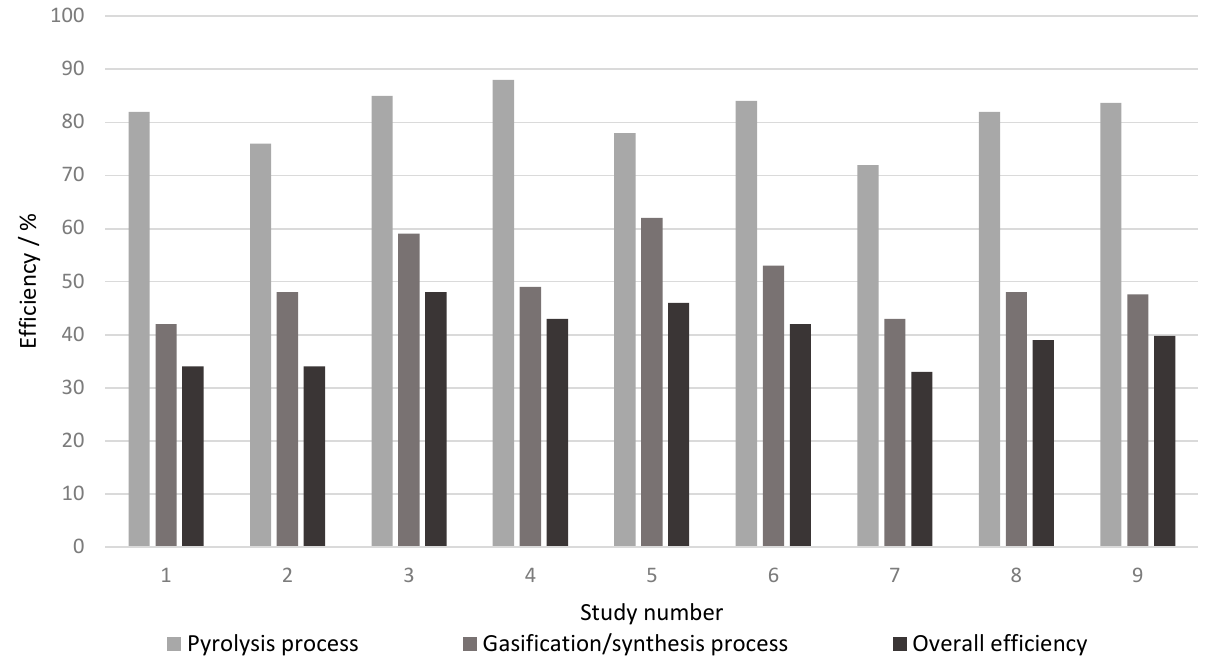
Figure 3. Conversion efficiencies of the local pyrolysis and the central gasification/synthesis processes together with those of the overall process in the investigated studies.